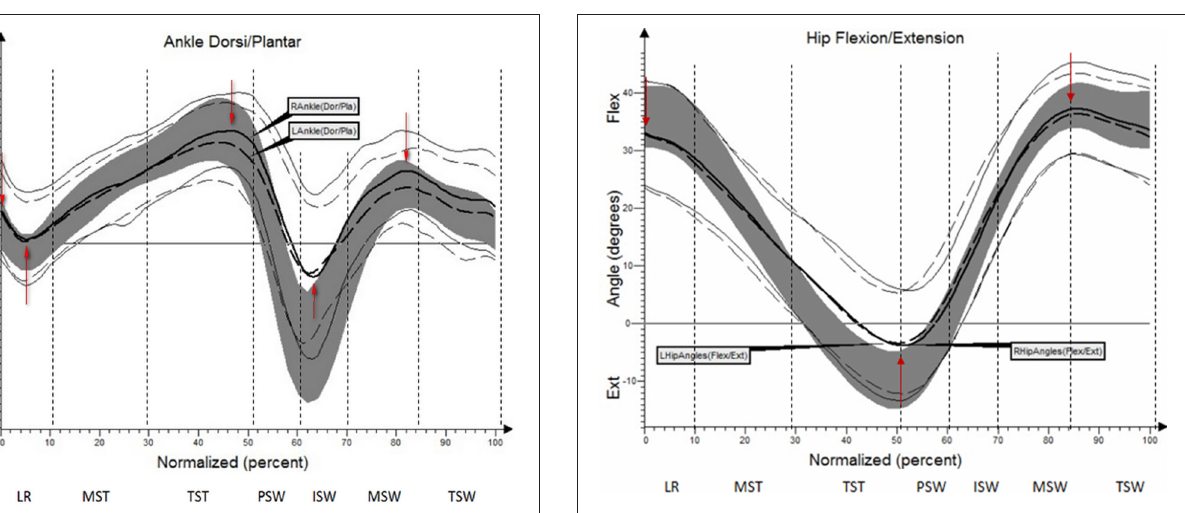
FIGURE 4 | Angular changes in the hip joint HD study group compared with control group.